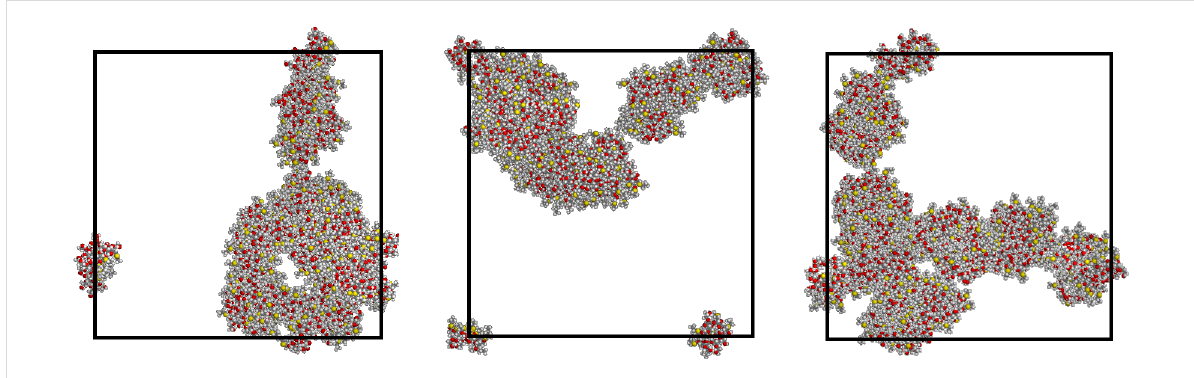
Figure 5: The first final arrangement of sixty-four molecules within the large periodic cell of 123.0 Å after an MD run of 50 ns viewed along the z -, y -, x -directions (from left to right). Due to the cell periodicity, some molecules at the cell edges are apparently separated from the whole clusters to which they belong.